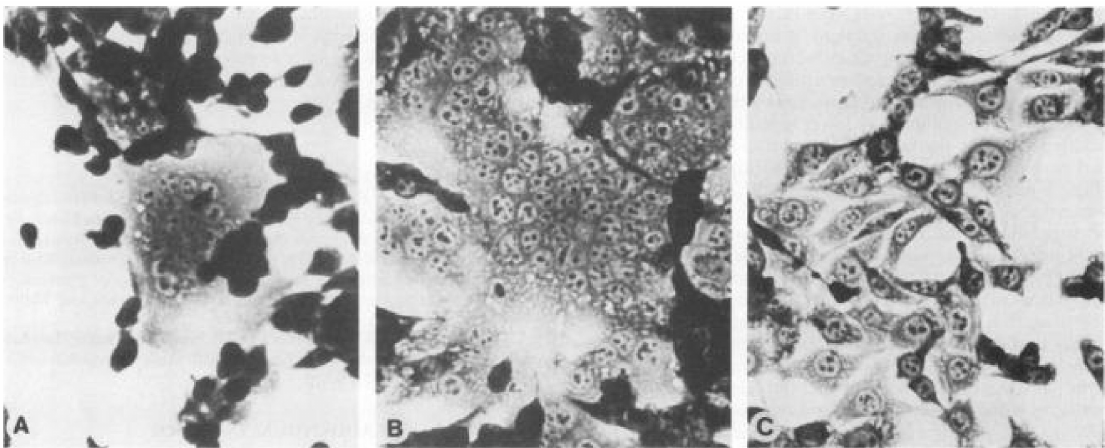
Figure 1. Syncytium Formation Induced by Expression of R- MLV Env. HEK 293T cells were transfected with a plasmid directing the expression of R- Env ( A , B ) or wild-type Env ( C ). Forty-eight hours later on’mouse cells were added to the cultures. The cultures were fixed and stained 3 1 ( A ) or 24 ( B , C ) after addition of mouse cells (from ref. 2